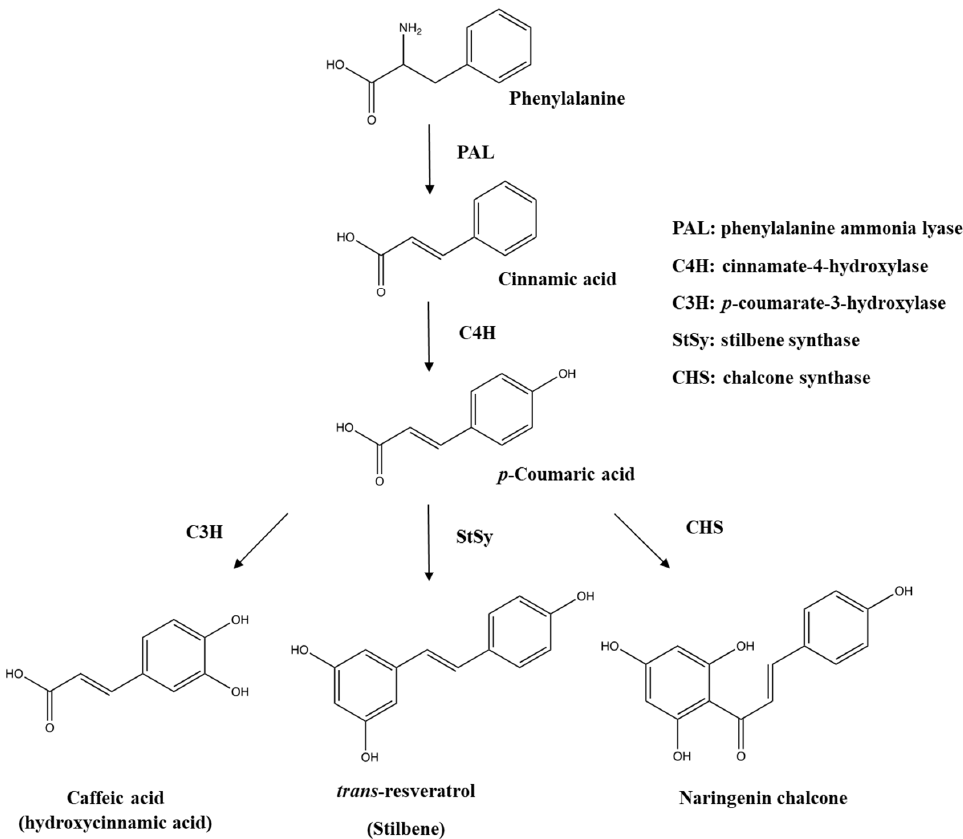
Figure 2. Biosynthesis pathway of phenolic acids and stilbene from phenylalanine.